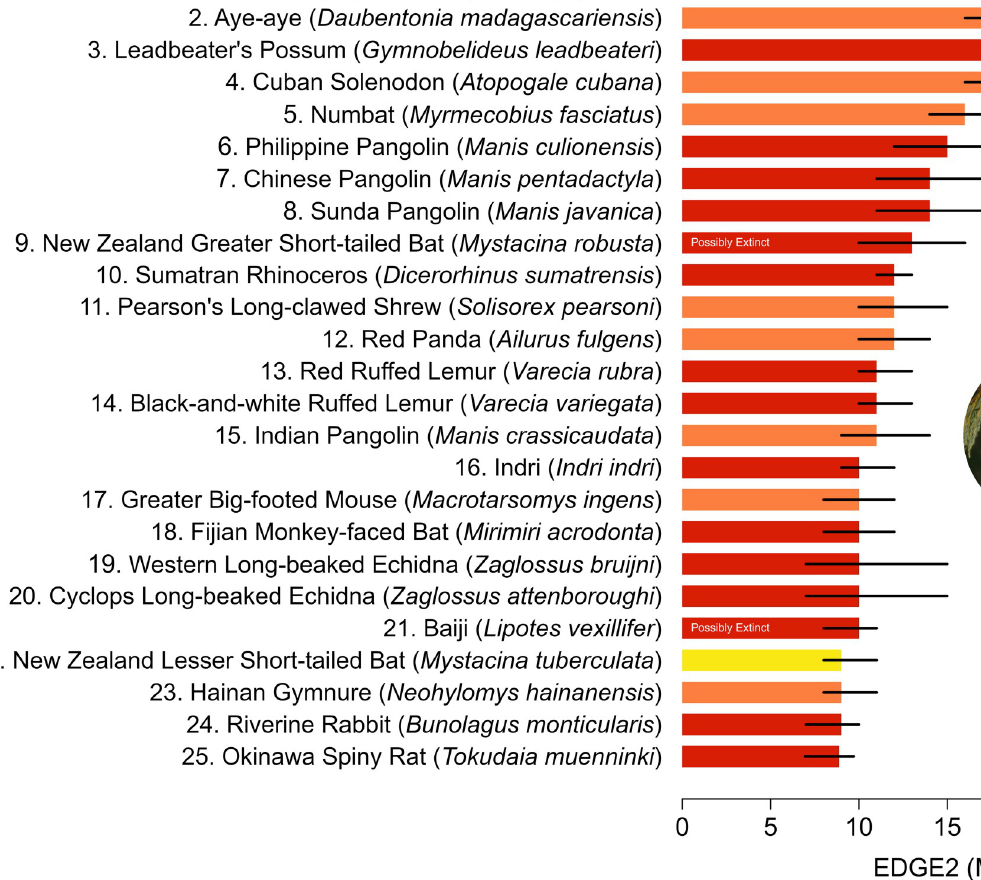
Fig 3. Top 25 EDGE2 Mammal species. The median EDGE2 (bars) and interquartile range of EDGE2 (error bars) for the 25 highest-ranking EDGE2 mammal species. EDGE2 scores calculated across a distribution of 1,000 phylogenetic trees. Colours of the bars represent IUCN Red List categories (red = CR, orange = EN, yellow = VU); “Possibly Extinct” denotes CR species marked with this tag on the Red List. The Full EDGE List is given in the S1 Data. The data underlying this Figure can be found in S2 Data. Image credits : Zoological Society of London . CR, Critically Endangered; EDGE, Evolutionarily Distinct and Globally Endangered; EN, Endangered; IUCN, International Union for Conservation of Nature; VU,